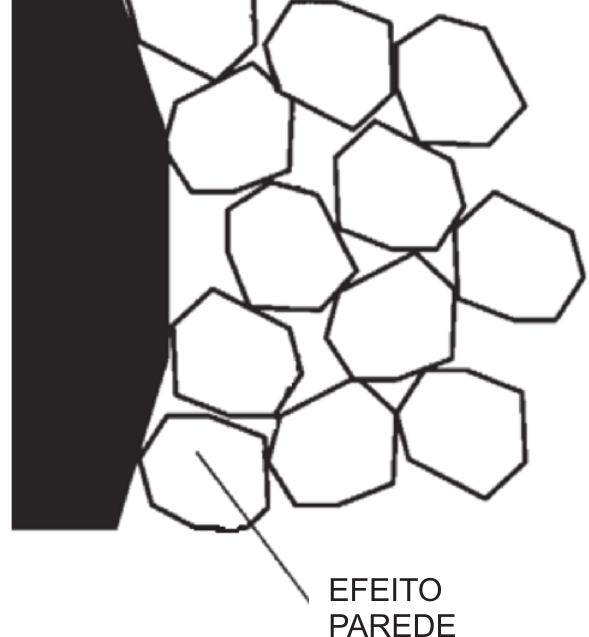
Efeito parede (adaptado de [16])